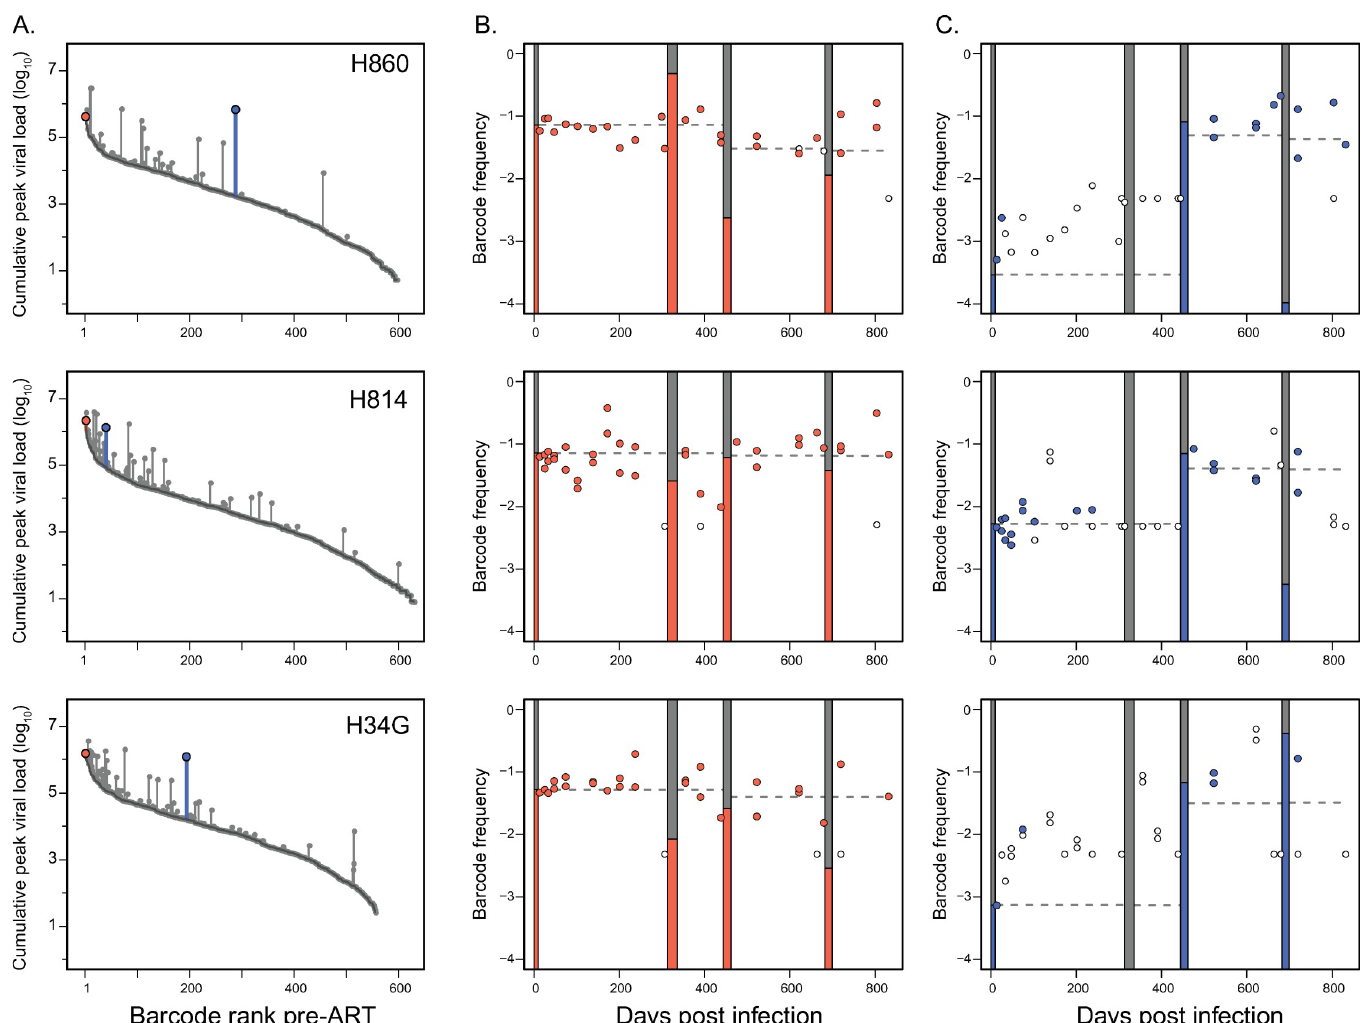
Fig 5. Frequency of rebounding lineages in CA-vDNA on ART reflects replication during ATIs. The relative DNA frequencies of select lineages that rebounded in ATI-3 are tracked in vDNA on ART for animals H860, H814, and H34G. In panel (A), the grey points correspond to the cumulative peak viral loads of barcodes, rank- ordered based on their relative frequency at d10. The dark grey lines depict the pre-ART barcode distribution, with increases in total viral load highlighted by vertical line segments. Select lineages that were dominant in pre-ART plasma viremia but subsequently increased negligibly in total viral load are highlighted in red, while variants with over 10-fold higher level of replication during ATI-2 than primary infection are highlighted in blue. In panel (B), the red filled circles depict the relative frequencies of predominant barcodes in vDNA while the open circles indicate the limit of detection at time points when a particular barcode was not observed. The grey bars highlight the time intervals when the animals were off therapy, with the red bars indicating the relative frequency of the barcode at peak viremia during each interval. In panel (C), the blue filled circles depict the vDNA frequencies of the lineages that replicated substantially during ATI-2, while the open circles indicate the limit of detection at time points when a particular barcode was not observed. The grey bars again highlight the time intervals when the animals were off therapy, with the blue bars indicating the relative frequency of that barcode at peak viremia during each interval. The dashed lines indicate the relative frequency of each lineage based on cumulative peak plasma viral